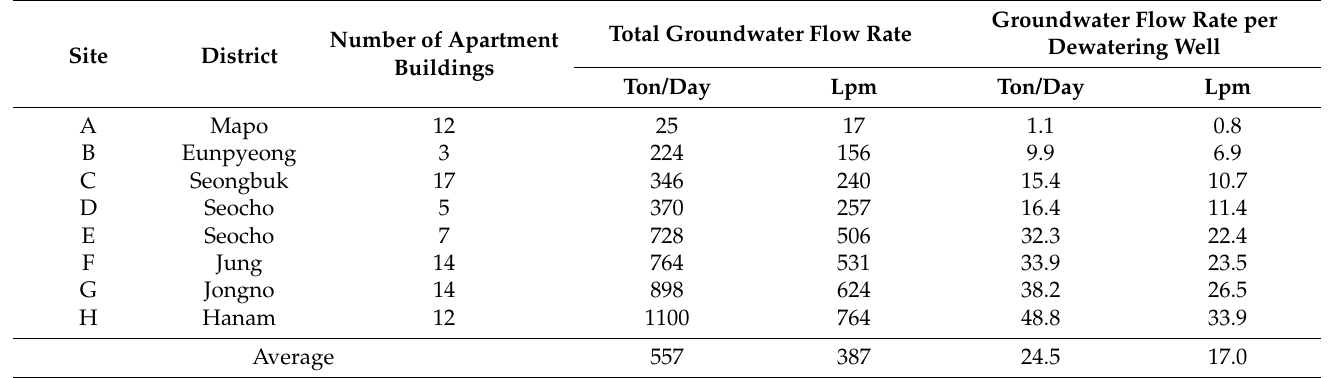
Table 3. Measured groundwater inflow rates for eight apartment